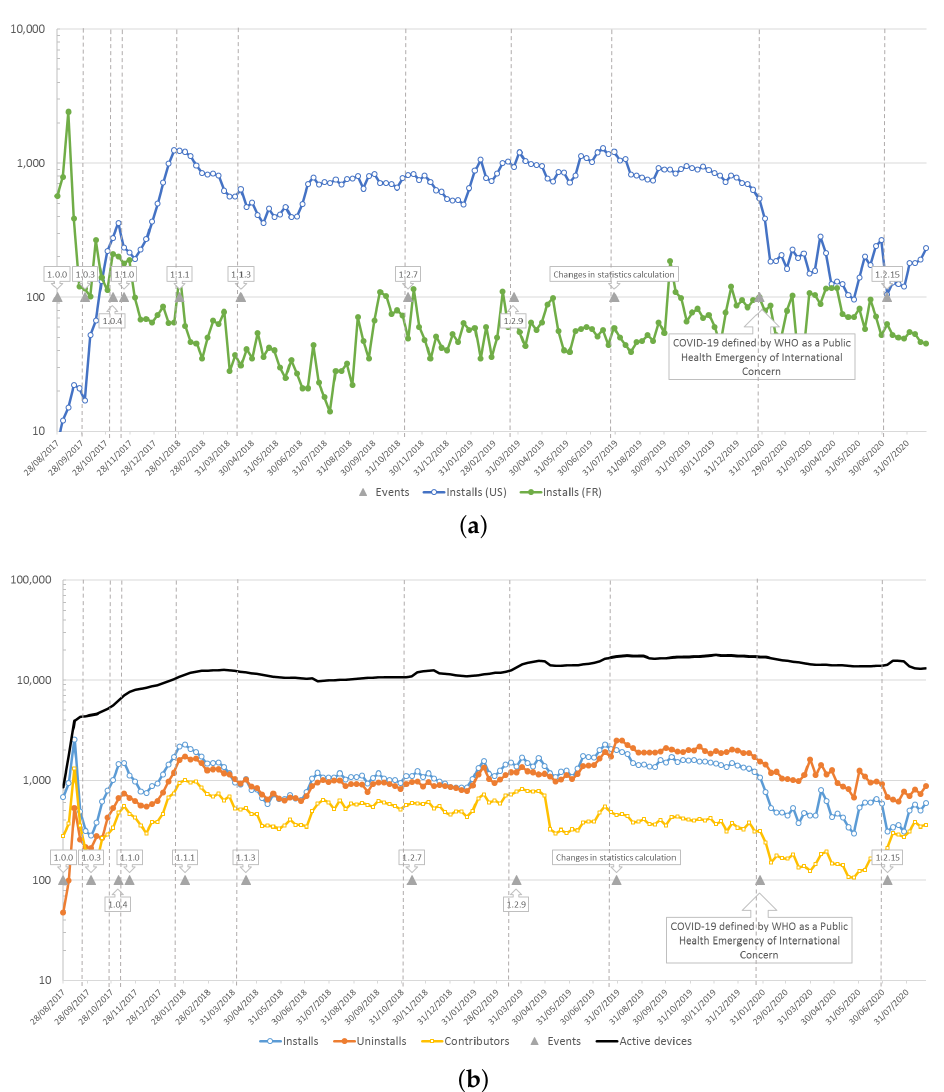
Figure 3. Weekly evolution of user installs and uninstalls of the NoiseCapture application (data from Google Play dashboard): ( a ) global data and ( b ) data for France and United states of America. ‘Installs’: number of users who have installed the application at least on one device; ‘Uninstalls’: users who have uninstalled the application from all their devices; ‘Active devices’: number of active devices that contains application, and which was turned on at least once in the previous 30 days; ‘Contributors’: Users who have upload data to the NoiseCapture remote server; ‘Events’: Events that may have a particular impact on the users behavior. ( a ) Application installs for France (FR) and United-States of America (US); ( b ) Application